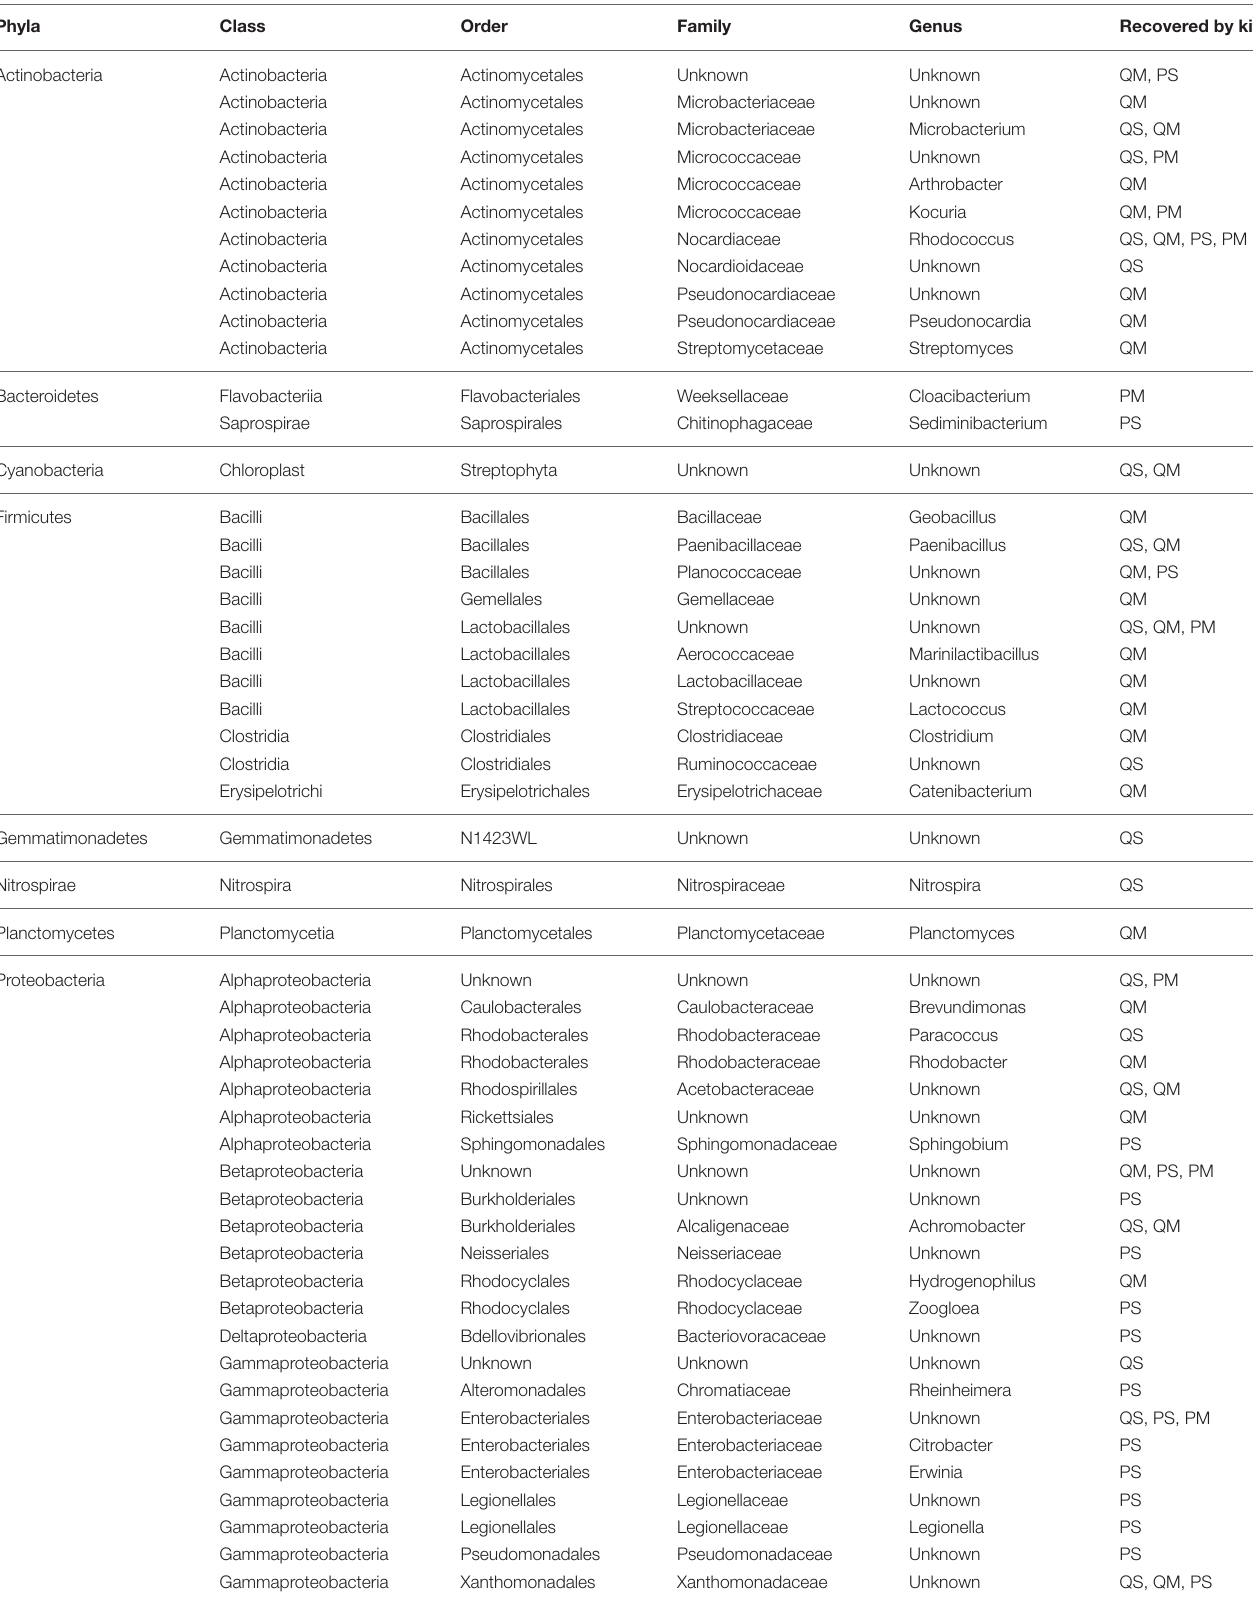
TABLE 3 | Summary of OTUs detected in meconium samples only, not in negative extraction controls or negative PCR controls.